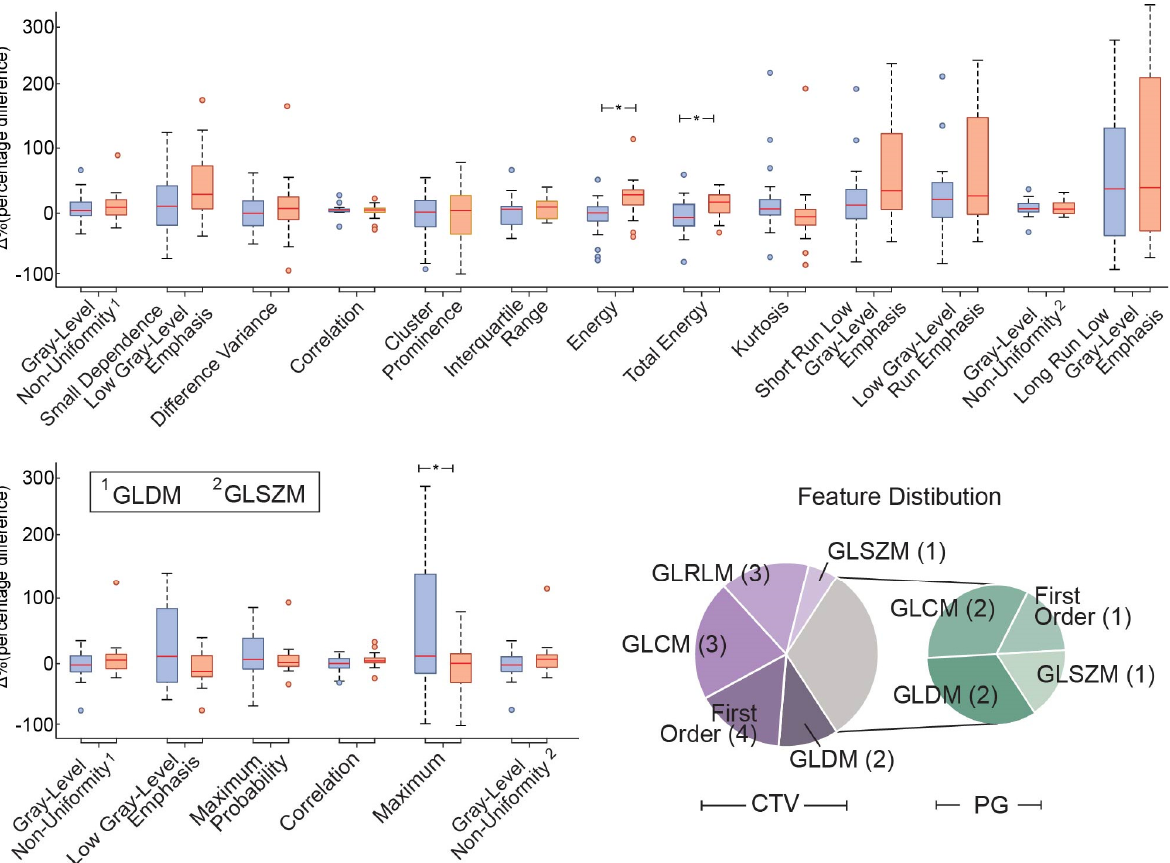
Figure 3. The radiomics feature incorporated in the optimal subset. The red central horizontal line in each box indicates the mean value, with the edges designating the 25th and 75th percentile, while the whiskers extend to the most extreme data points. Outliers are marked with the “o” symbol, whereas “*” indicated the significant ANOVA p -value < 0.05. Regarding the Gray − Level Non − Uniformity feature case, the number over the feature names indicates the different feature families with 1 being GLDM and 2 GLSZM. The pie charts represent the distribution of the PG and CTV ROIs features with respect to the feature families.